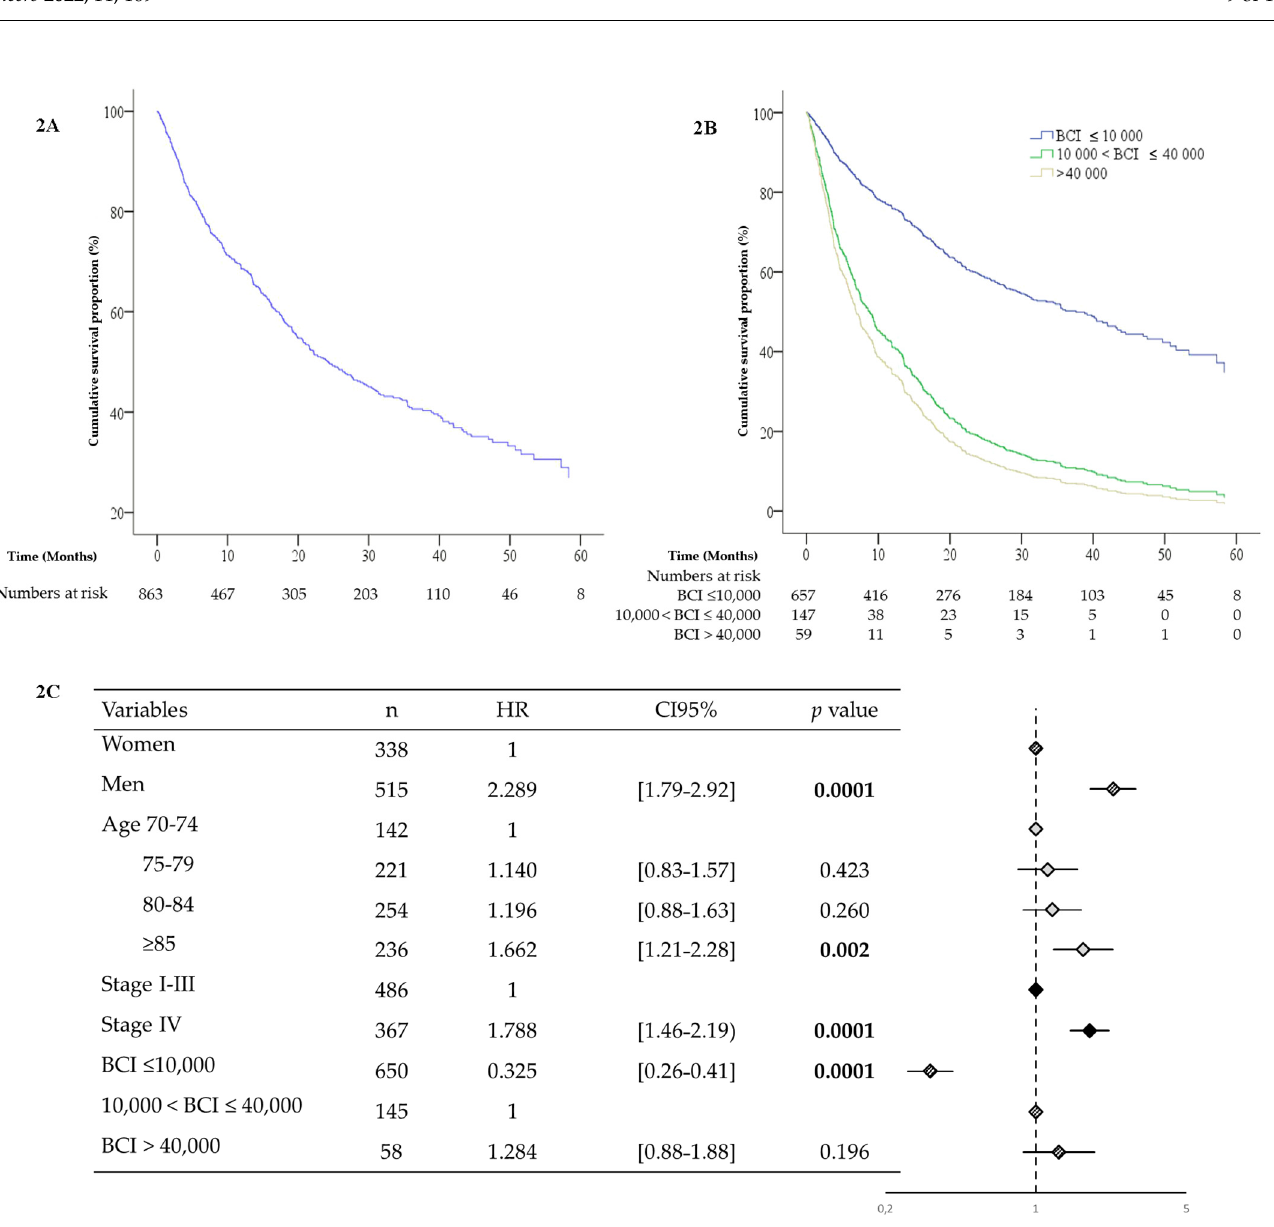
Figure 2. Overall survival time (panel A ), overall survival time according to BCI level and BCI group (panel B ), multivariate COX survival analysis (panel C ). BCI: B12/CRP index; aHR: adjusted hazard ratio. Significant p -values were highlighted in bold.